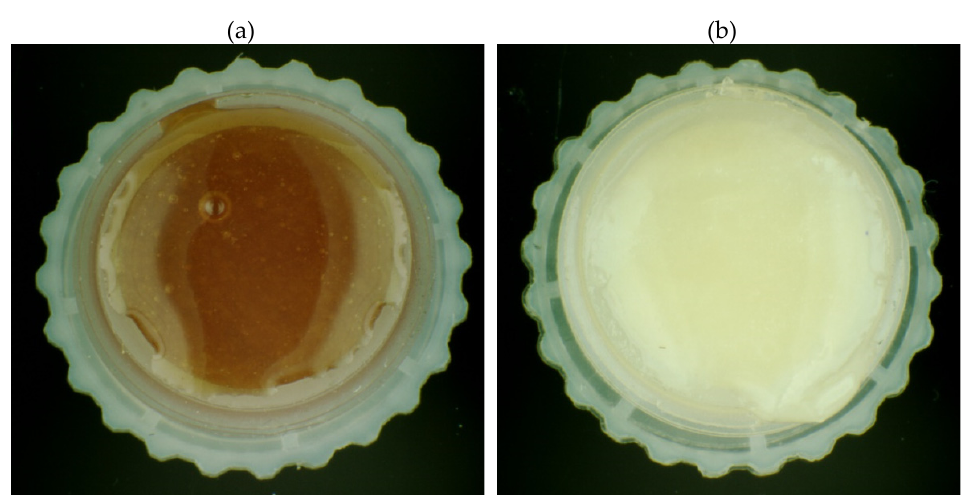
Figure 1. Photo of conventional buckwheat honey ( a ) and ecological forest honey ( b ).